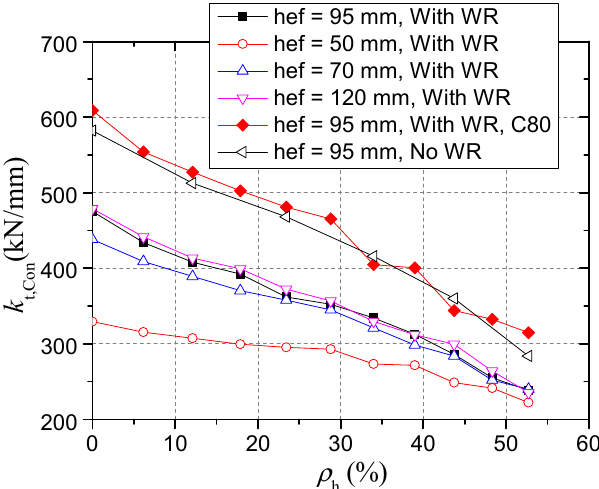
Figure 19. Relationship between the tensile stiffness and the damage degree.